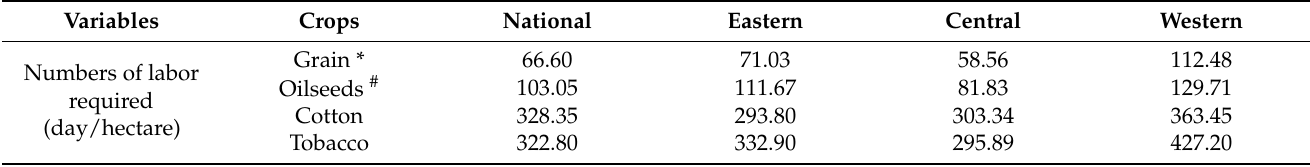
Table 8. The numbers and costs of labor required for grain and cash crops in China in